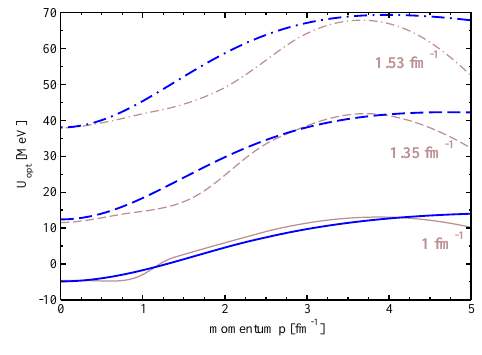
Figure 1. Optical potential of Λ -hyperons as function of their momentum p in symmetric nuclear matter at saturation density. The NLD-results (thick-solid curve) are compared with χ -EFT microscopic calculations at different orders LO (band with closed dashed borders) and NLO (band with closed solid borders). Further mi- croscopic calculations of the Jülich group (dot-dashed curve) are shown too.